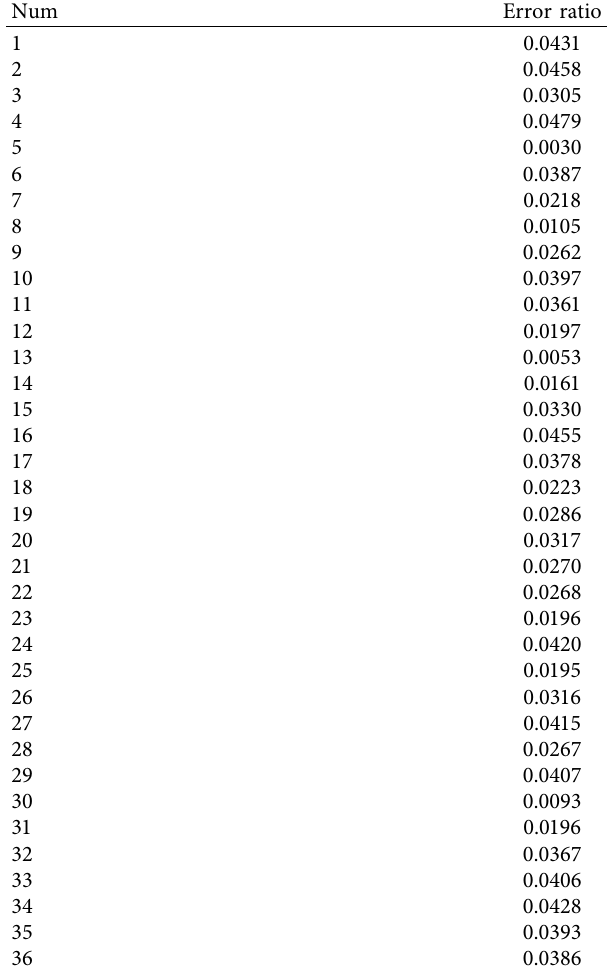
Table 1: Statistical table of the motion error of robotic arm.